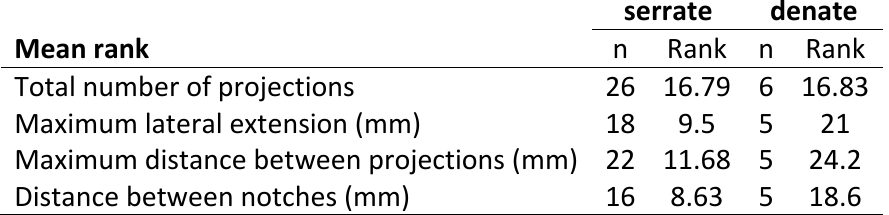
Table 9. Mean rank for projection metrics and raw material groups.